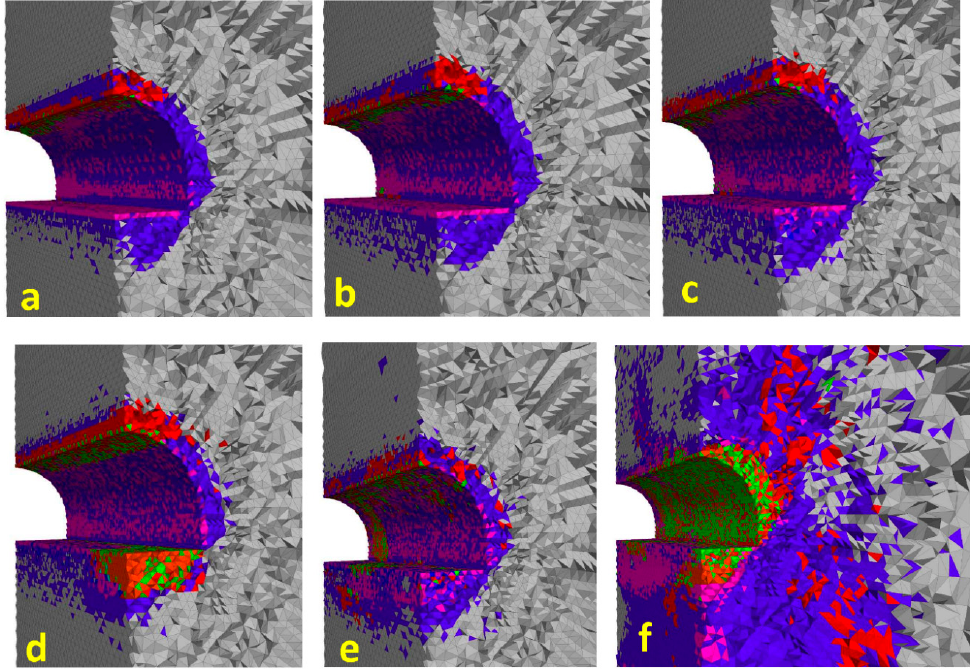
Figure 8. Plasticization zones in the model with the distribution of strength parameters only, variability coefficients: ( a ) 5%, ( b ) 10%, ( c ) 15%, ( d ) 20%, ( e ) 25%, ( f ) 30%.